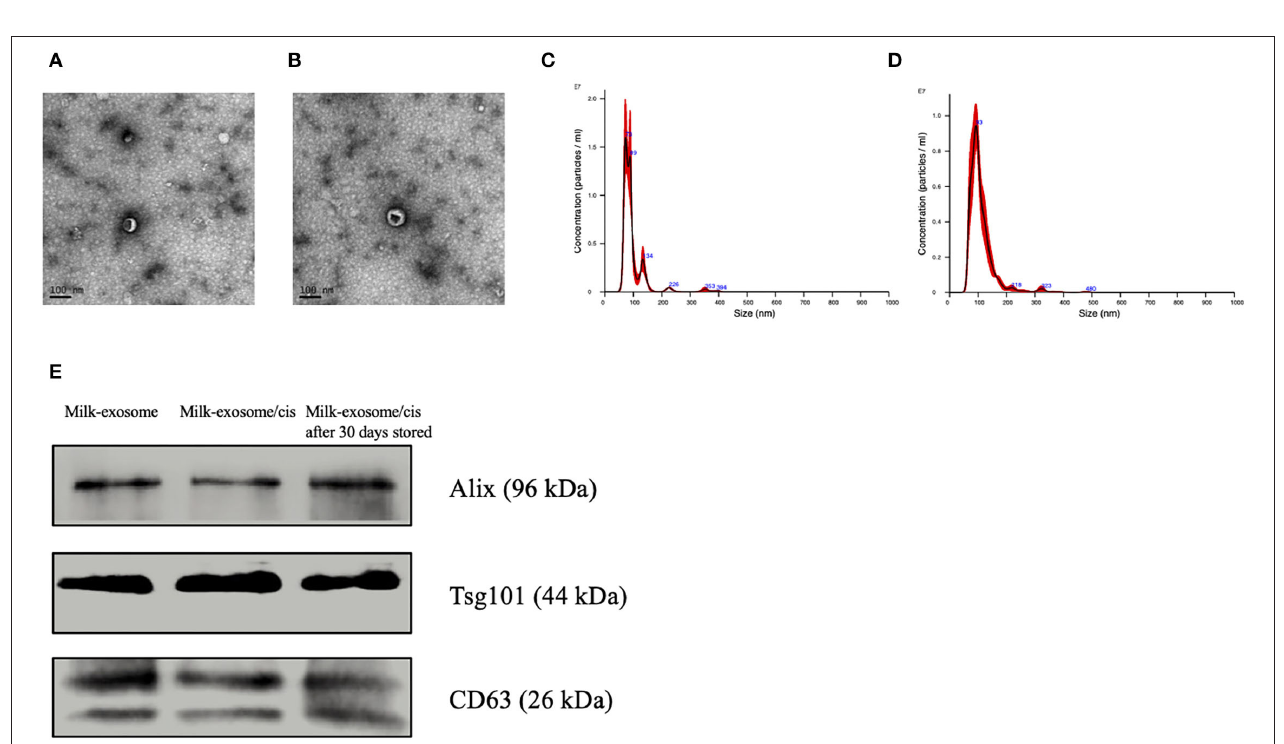
FIGURE 2 | Characterization of milk-exosomes and milk-exosome/cis. (A,B) Electron microscopy analysis of milk-exosomes and milk-exosome/cis. Scale bar represents 100nm. (C,D) Size distribution profile of milk-exosomes and milk-exosome/cis as detected by NanoSight. (E) Western Blot analysis of Alix, CD63 and Tsg101 in milk-exosomes, milk-exosomes/cis and stored milk-exosomes/cis.